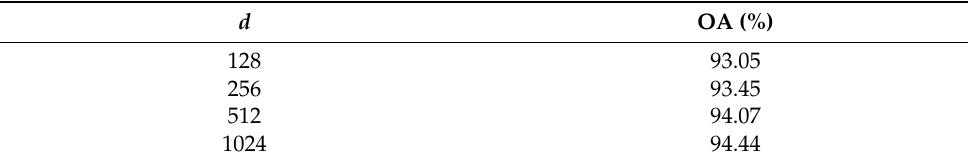
Table 1. Influence of parameter d on classification